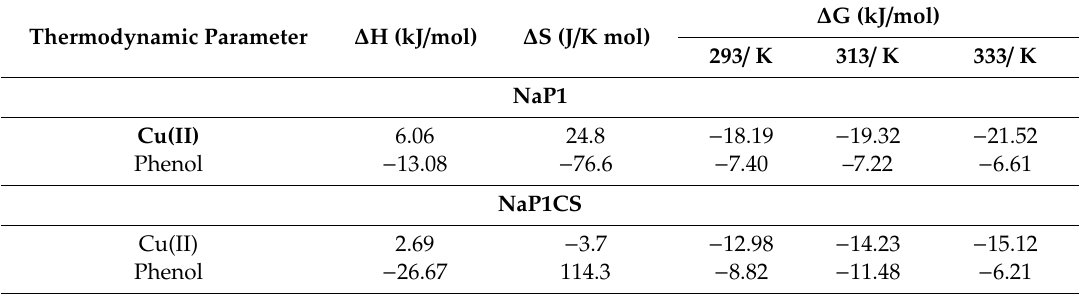
Table 7. Thermodynamic parameters for the sorption of Cu(II) ions and phenol on NaP1 and NaP1CS. Thermodynamic Parameter ∆ H (kJ / mol) ∆ S (J / K